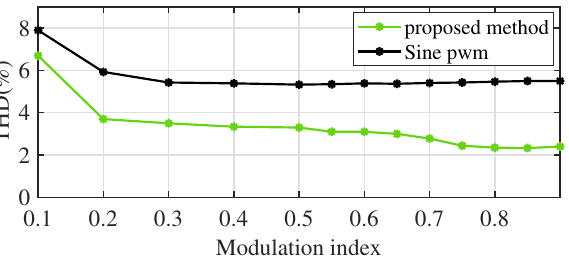
Figure 19. Voltage THD (%) for the proposed method and Sine PWM method for different modulation indices, where dc link voltage is the rectified output of a three-phase diode bridge rectifier circuit.